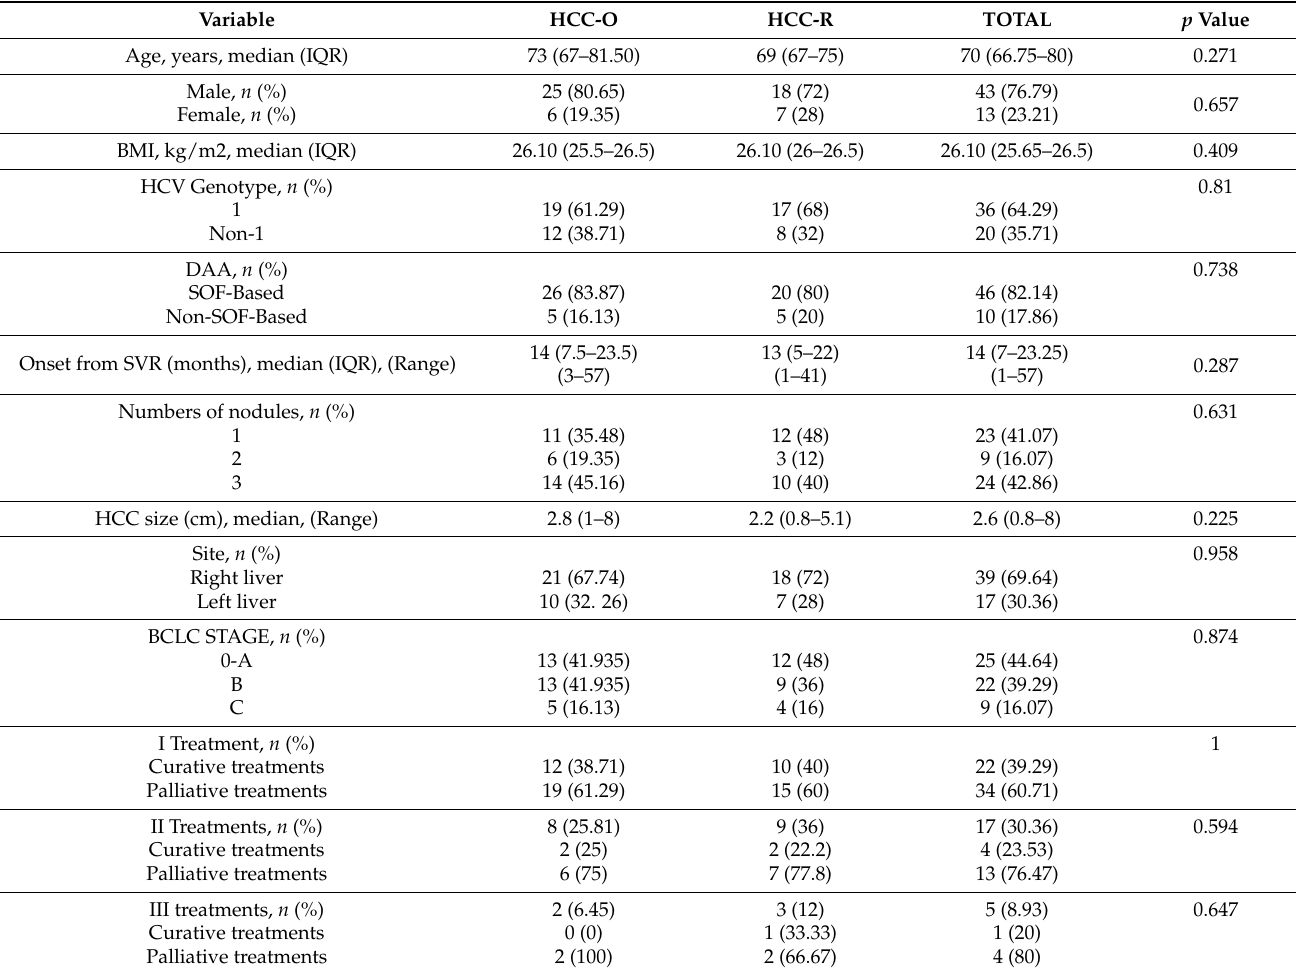
Table 2. Main characteristics of de novo occurrent and recurrent